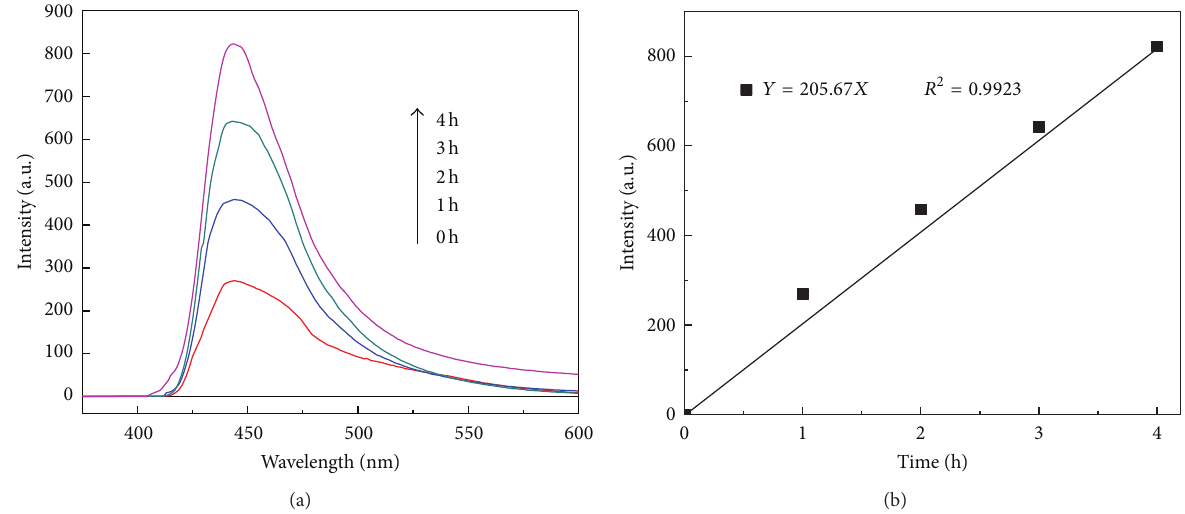
Figure 8: (a) ∙ OH-trapping photoluminescence spectra of 1%-Pr-BSO in solution of terephthalic acid at room temperature (ex, 312nm; em, 426 nm) and (b) plots of the induced PL intensities of 1%-Pr-BSO at 426 nm on the irradiation time.